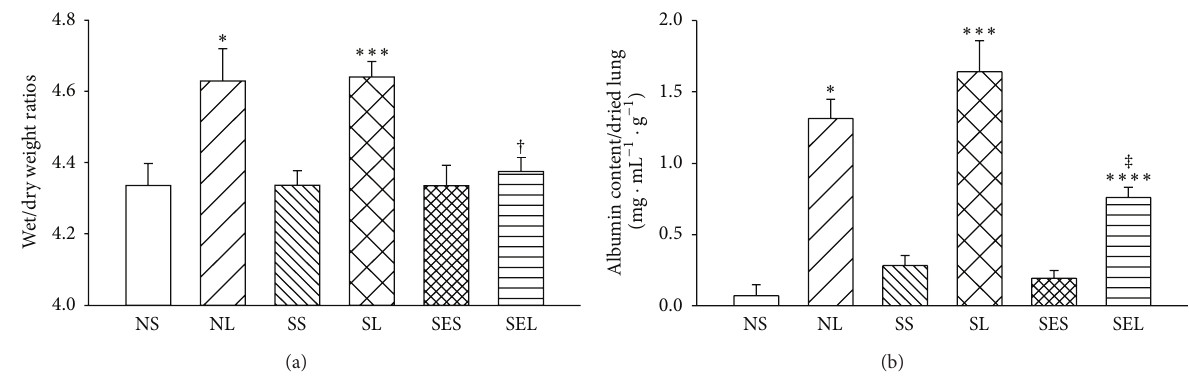
Figure 5: The lung wet/dry weight ratios and albumin content in lung lavage at 240min after administration of saline or LPS. Albumin content in the brochoalveolar lavage fluid was calculated as [(mg of albumin)/(mL of lavage fluid)]/(g of dried lung weight). NS: nondiabetic rats injected with saline; NL: nondiabetic rats injected with LPS; SS: STZ-induced diabetic rats injected with saline; SL: STZ-induced diabetic rats injected with LPS; SES: STZ-induced diabetic rats with exercise injected with saline; SEL: STZ-induced diabetic rats with exercise injected with LPS. Data are expressed as the mean ± SEM of eight rats per group. ∗ 𝑃 < 0.05 , compared with the NS group; † 𝑃 < 0.05 , compared with the NL group; ∗∗∗ 𝑃 < 0.05 , compared with the SS group; ‡ 𝑃 < 0.05 , compared with the SL group; ∗∗∗∗ 𝑃 < 0.05 , compared with the SES group (one-way